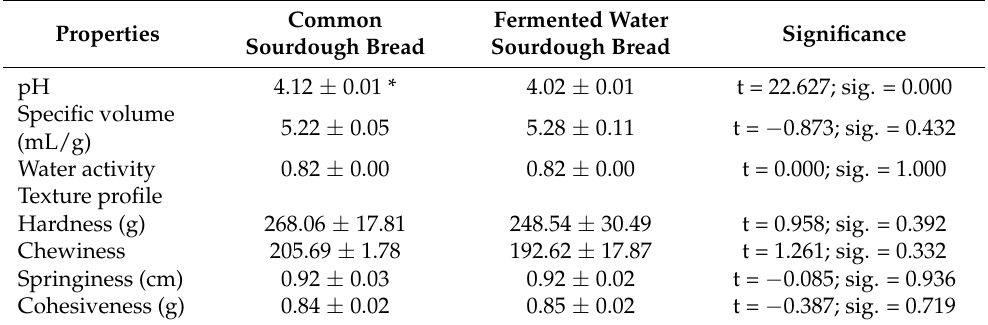
Table 2. pH, specific volume and texture profile of common sourdough bread and fermented water sourdough